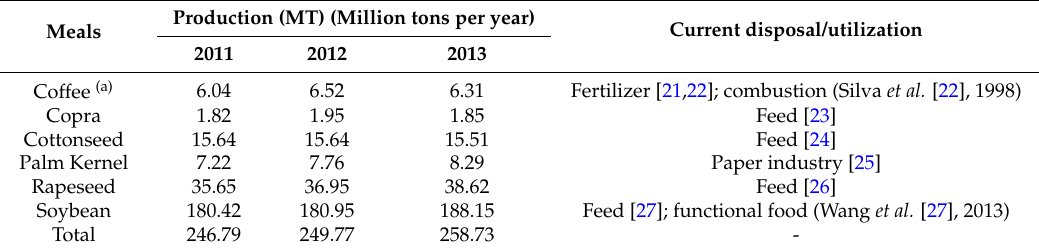
Table 1. Global annual production of industrial food wastes (IFWs) [20] and current disposals/utilization.